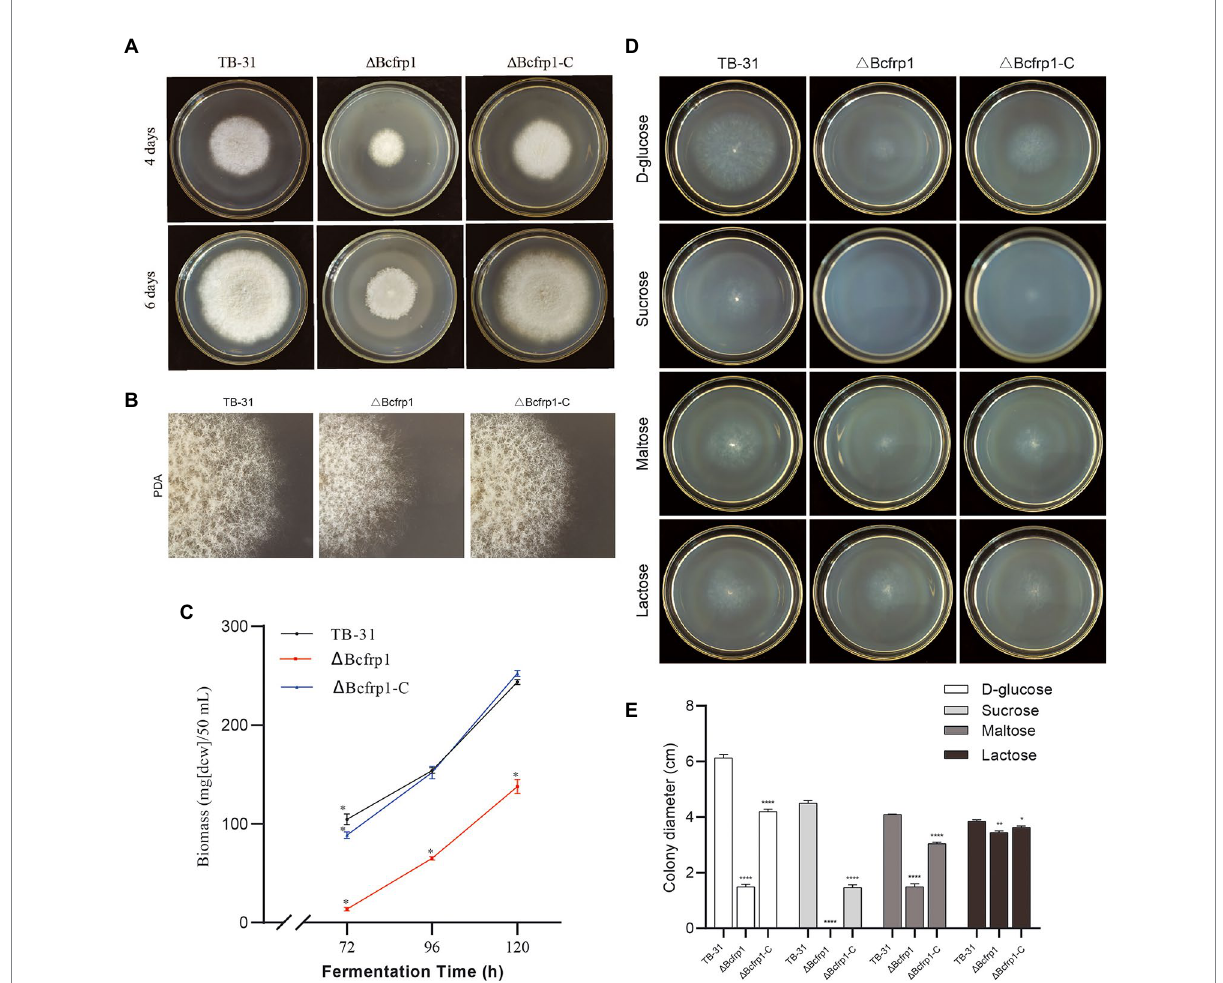
FIGURE 2 The biomass and colony morphology of B. cinerea TB-31, Δ Bcfrp1 and Δ Bcfrp1-C. (A) The morphology of TB-31, Δ Bcfrp1 and Δ Bcfrp1-C on PDA media for 4 days and 6 days. (B) The morphology of TB-31, Δ Bcfrp1 and Δ Bcfrp1-C on PDA media for 4 days and 6 days. All images were captured at 3X magnification. (C) Biomass of TB-31, Δ Bcfrp1 and Δ Bcfrp1-C on PDB media at 26 ° C at 180 rpm on an orbital shaker. The mycelia were collected at three time points (72, 96, and 120 h). Shown are means ± SEM; n = 3 replicate cultures. *, p < 0.05 versus the biomass of the TB-31 group. (D) The colony morphology of TB-31, Δ Bcfrp1 and Δ Bcfrp1-C on CDA media with 2% D-glucose, 2% Sucrose, 2% Maltose, and 2% Lactose plates and cultured at 26 ° C for 6 days. (E) Colony diameters of the TB-31, Δ Bcfrp1 and Δ Bcfrp1-C strains on CDA media with 2% D-glucose, 2% Sucrose, 2% Maltose, and 2% Lactose cultured at 26 ° C for 6 days. Shown is means ± SEM; n = 3 replicate cultures. *, p < 0.05 versus colony sizes of the TB-31 group; **, p < 0.01 versus the transcription level of the TB-31 group; ****, p < 0.001 versus the transcription level of the TB-31